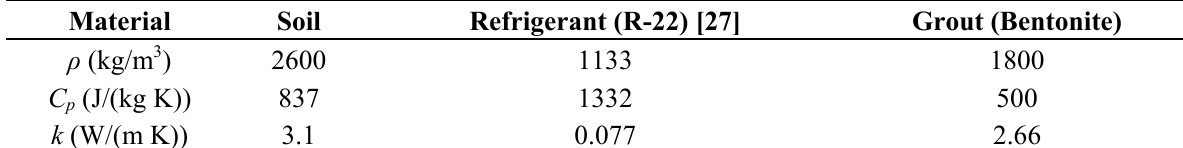
Table 2. Properties of the element of the ground heat